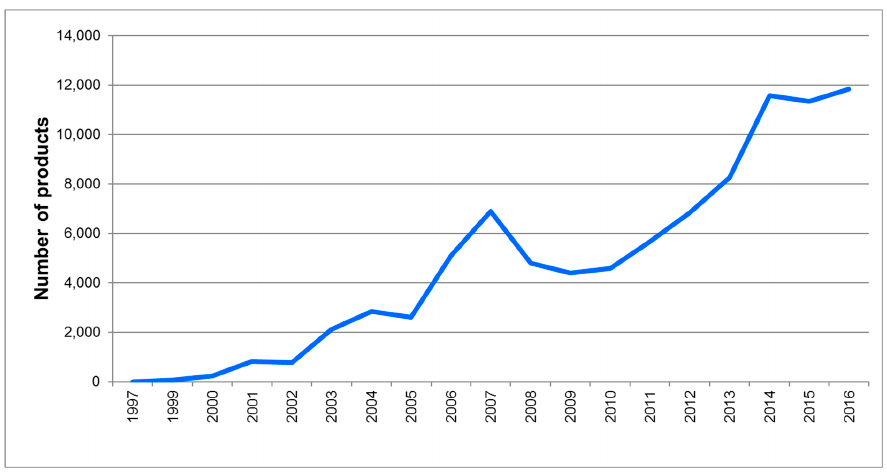
Figure 1. Number of products launched during 1997–2016. Source: Own elaboration based on Mintel’s Global New Products Database (GNPD) data.